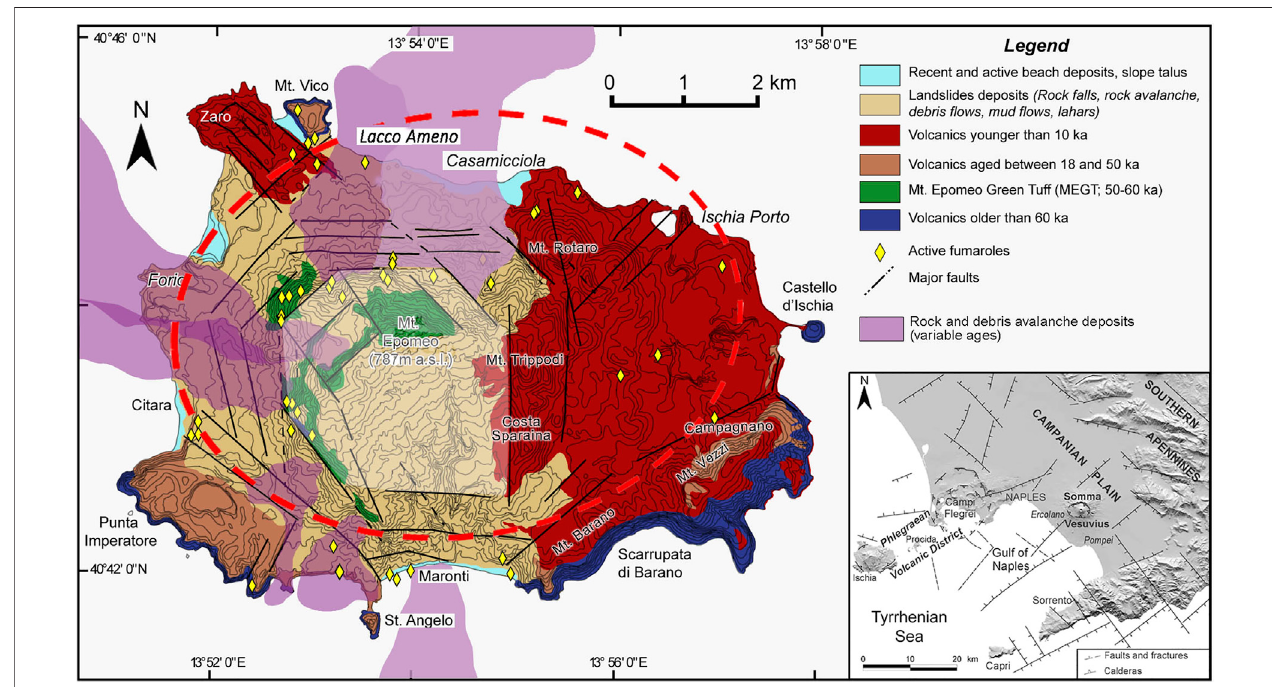
FIGURE 1 | Geological sketch map of Ischia Island (modi fi ed after Sbrana et al. (2018) and Della Seta et al., (2021)). The shaded area highlights the most uplifted part of the resurgent block; the red dashed line indicates the inferred collapsed area.